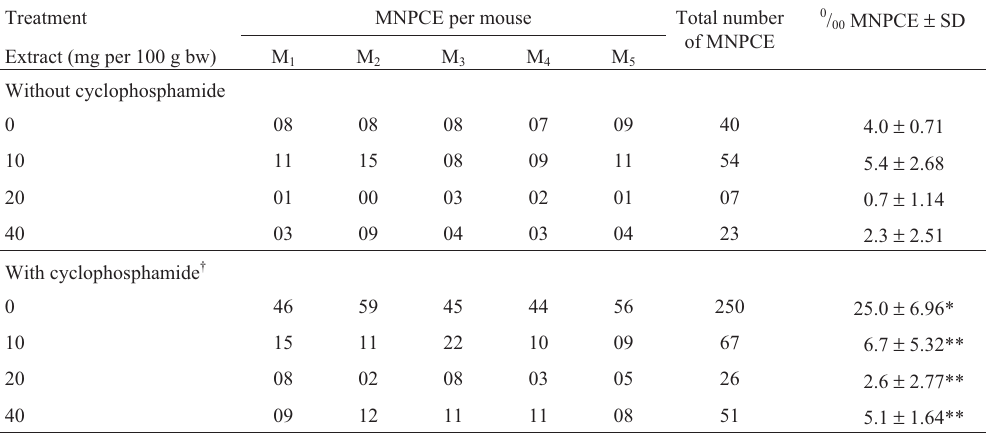
Table1 -Mousebonemarrowmicronucleustestresultsshowingthefrequencyofmicronucleated(MN)polychromaticerythrocytes(PCE)inmaleSwiss albinomicetreatedwith Mandevillavelutina crudeextract(CE)withandwithoutcyclophosphamide.Therewerefivemice(n=5;M 1 toM 5 )ineachtreat- mentand2000PCEwerecountedforeachmouse.Sinceeachmouseweighed25gto35gtheextractdosesforthetreatmentsare‘equivalentto’.Theneg- ative control was distilled water, shown by zero in the first column under the heading ‘Without cyclophosphamide’. The positive control was cyclophosphamide only at the equivalent of 0.2 mg per 100 g body weight (bw), shown by zero in the first column under the heading ‘With cyclophosphamide’. Statistical analysis was by pair-wise comparisons using the nonparametric Mann-Whitney U test with the level of significance set at α = 0 .